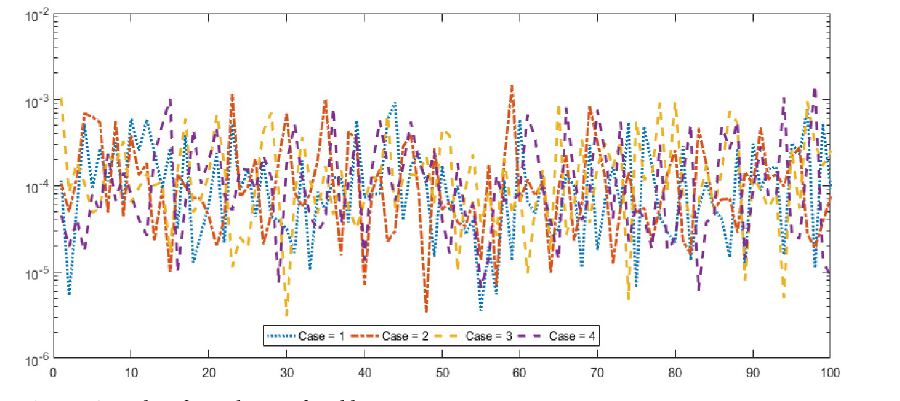
Fig 9. MAD values for each case of problem 2.